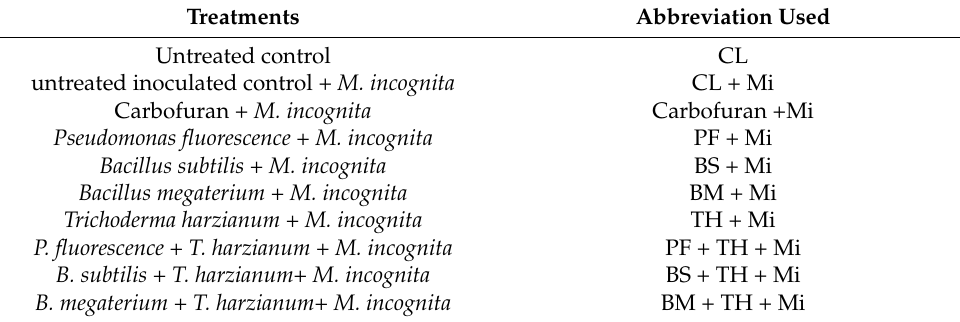
Table 1. Description of the treatments and abbreviations used in the